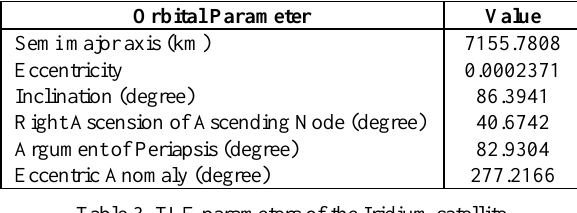
Figure 7. The schematic view of the path of two fictitious satellites (Sat_1 (up), Sat_2 (down)) Also, in SSM, based on the TLE parameters of the Iridium satellite that it is given in Table 3, a streak satellite with 20 pixels length is created. The trajectory of the Iridium satellite is Figure 6. The stars brighter than 7 Mv (blue points) in 1 degree shown in Figure 8. FOV in celestial sphere